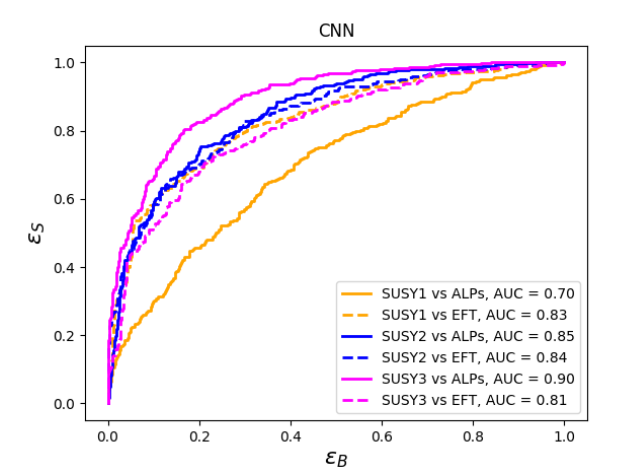
Figure 12: ROC curves (CNN with 2D histograms, r = 20) for SUSY WIMP bench- marks versus other signals, for the monojet case with 50K events are used for each signal.